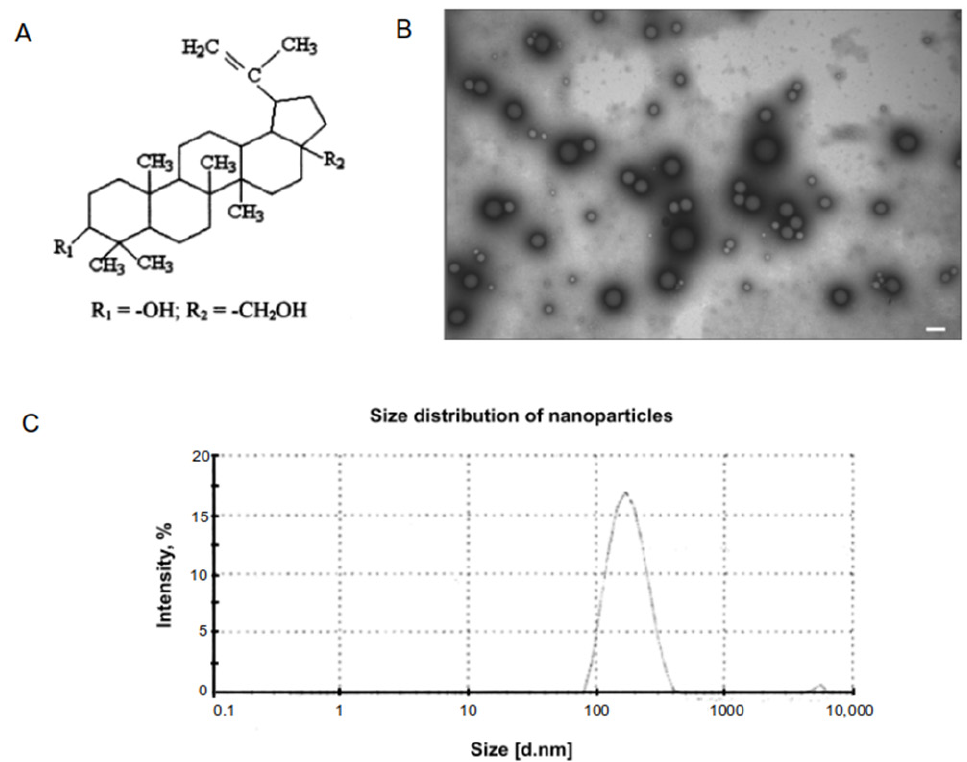
Figure 2. Characterization of betulin-based nanoparticle adjuvant. ( A ) Chemical structure of betulin; ( B ) TEM of betulin nanoparticles. Bar corresponds to 200 nm; ( C ) Betulin particle size analysis by Laser Dynamic Light Scattering.